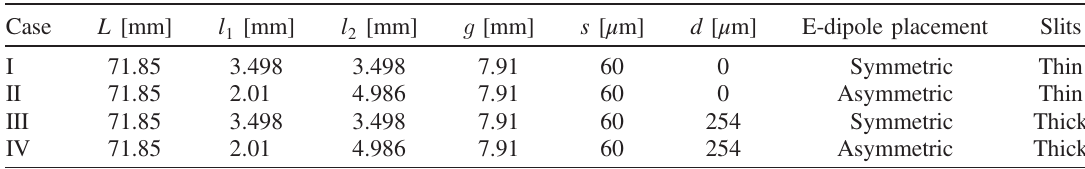
TABLE I. Geometric parameters applied in examples corresponding to the four geometric models in Fig. 2.